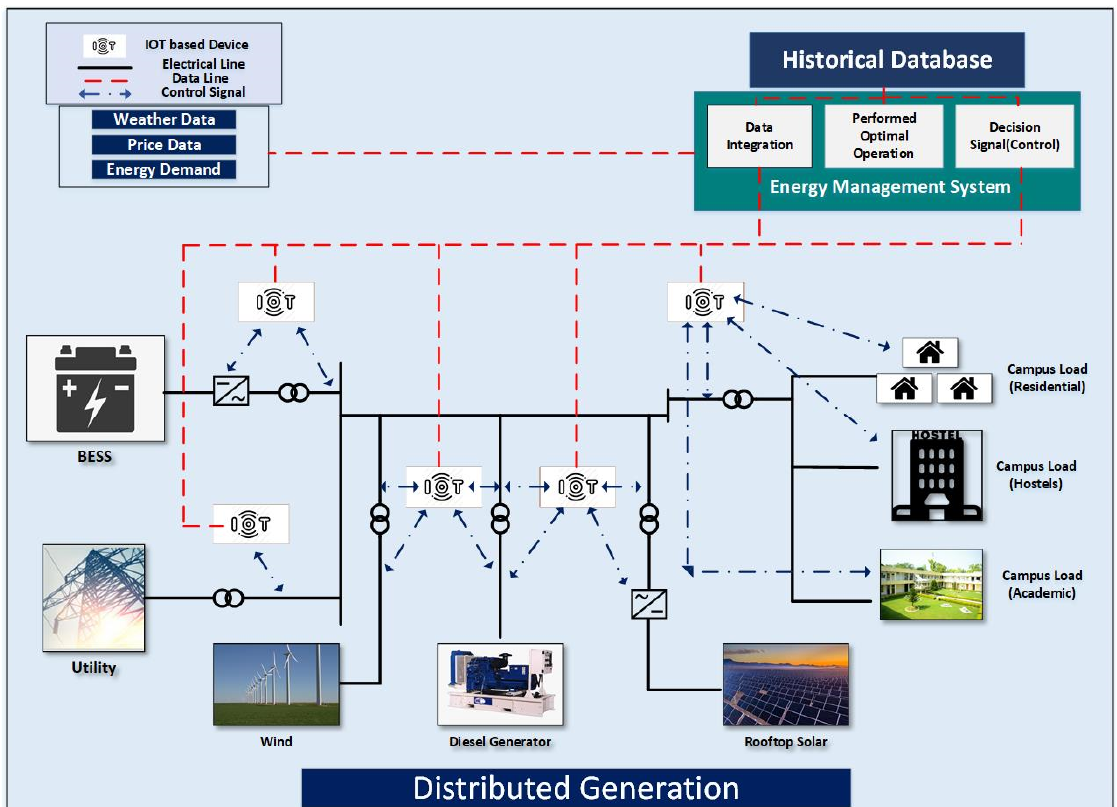
Figure 2. Proposed architecture of the system.